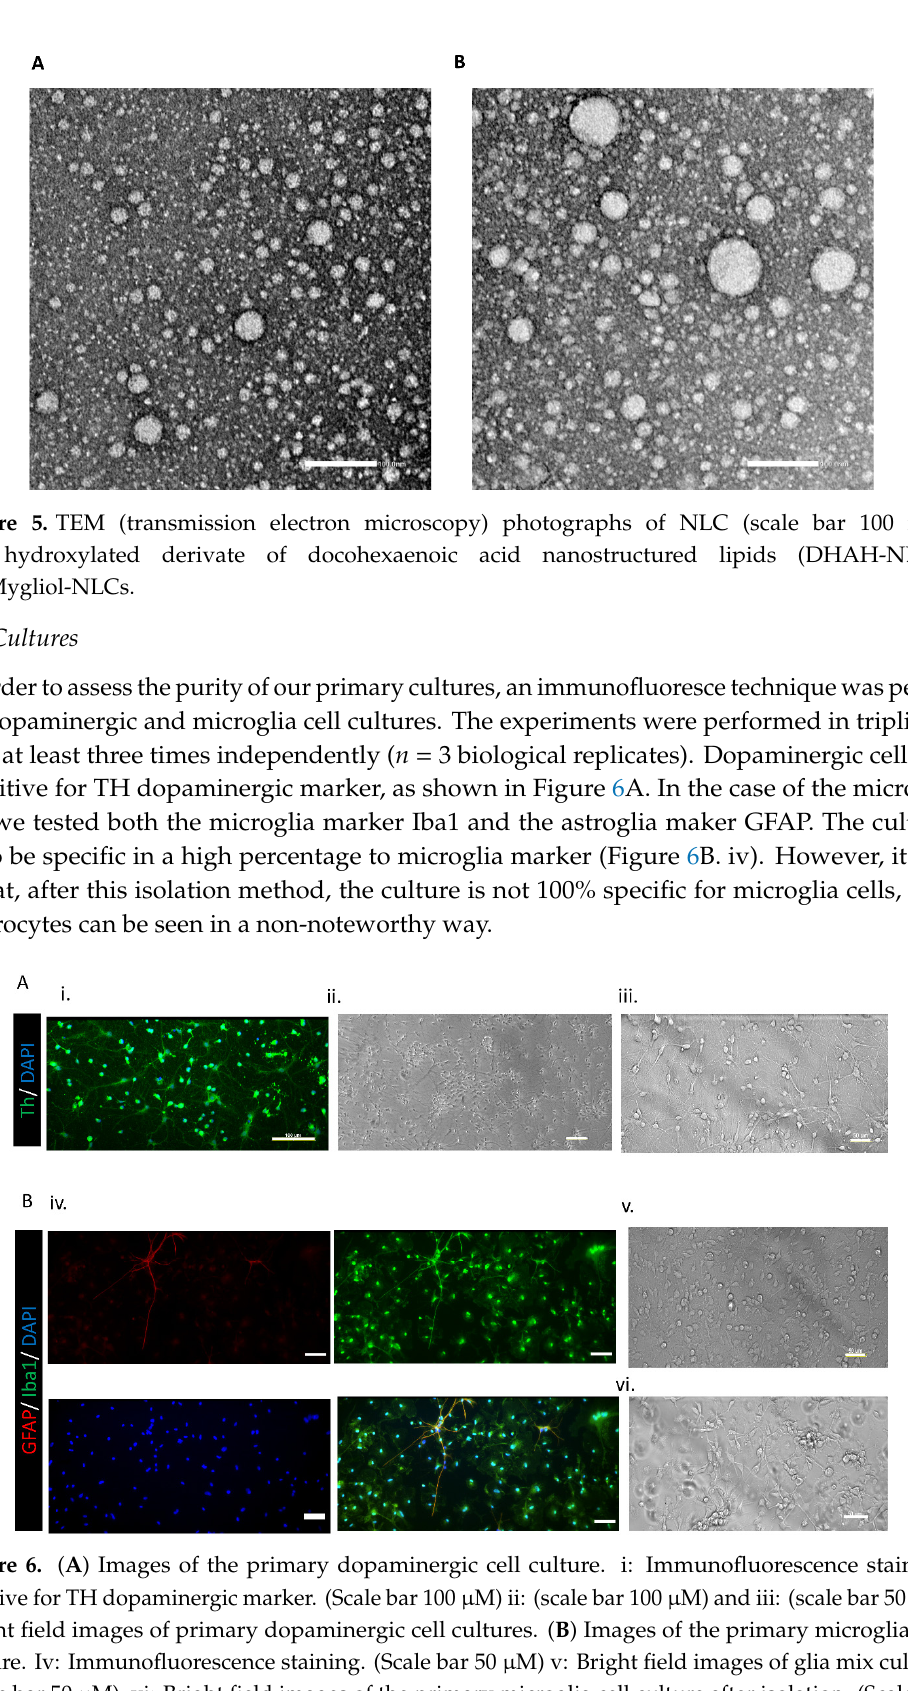
Table 3 . Characterization of the final nanoformulations used for cell culture tests. ( n = 2 independent experiments) .